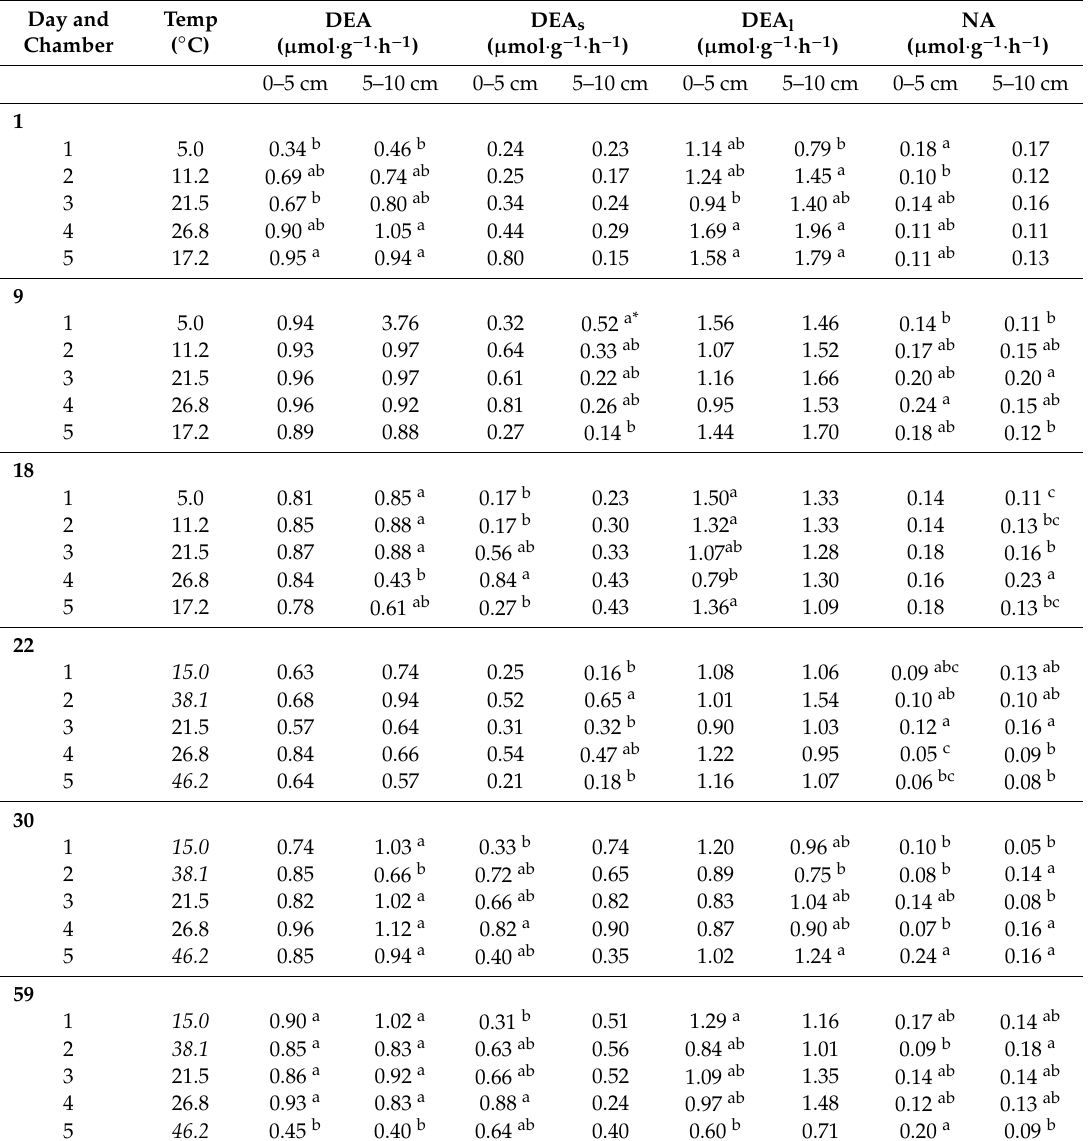
Table 2. Denitrifier enzyme activity (DEA) and nitrification enzyme activity (NA) in five chambers (1, 2, 3, 4, and 5) that received two simulated rainfall episodes. Chambers were held at temperatures ranging from 5.0 to 46.2 ◦ C, with increases on Day 22 (changes in italics). Samples were taken at 0–5 cm and 5–10 cm depths. Temperatures denoted in bold italics increased on Day 22. DEA rates were calculated as follows: (1) DEA, 0–54 h incubation; (2) DEA s , 0–24 h incubation; (3) DEA l ,